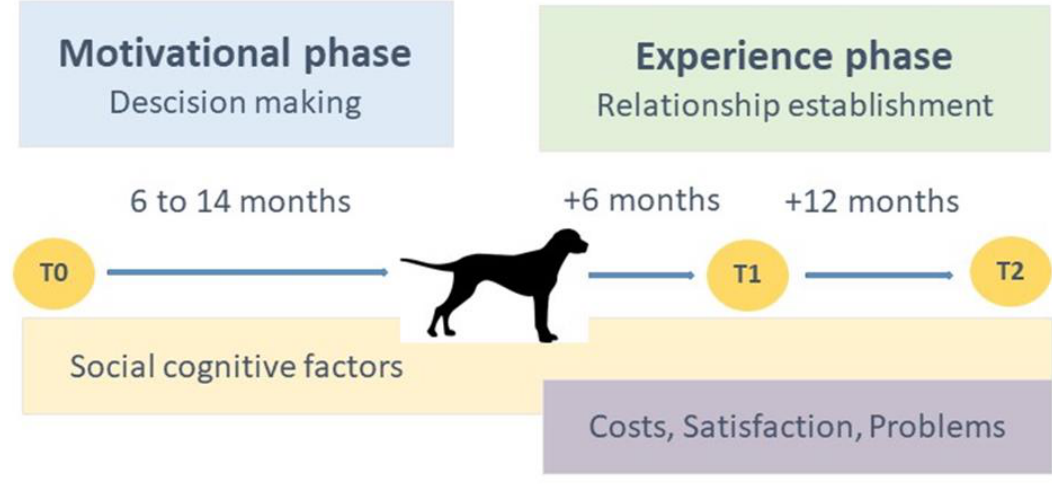
Figure 1. Two-phase model of the owner–dog relationship establishment and the research design of the present study.